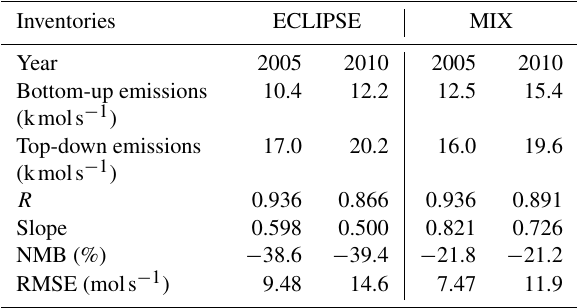
Table 5. Top-down NO x emission evaluations over China a